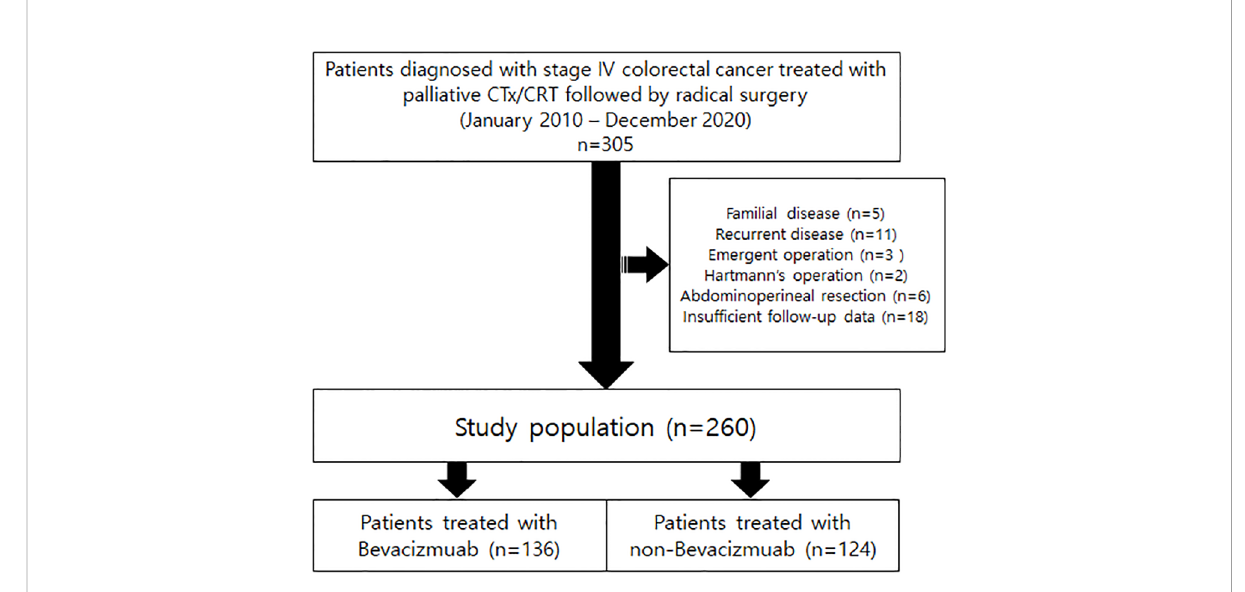
FIGURE 1 Flowchart showing study population